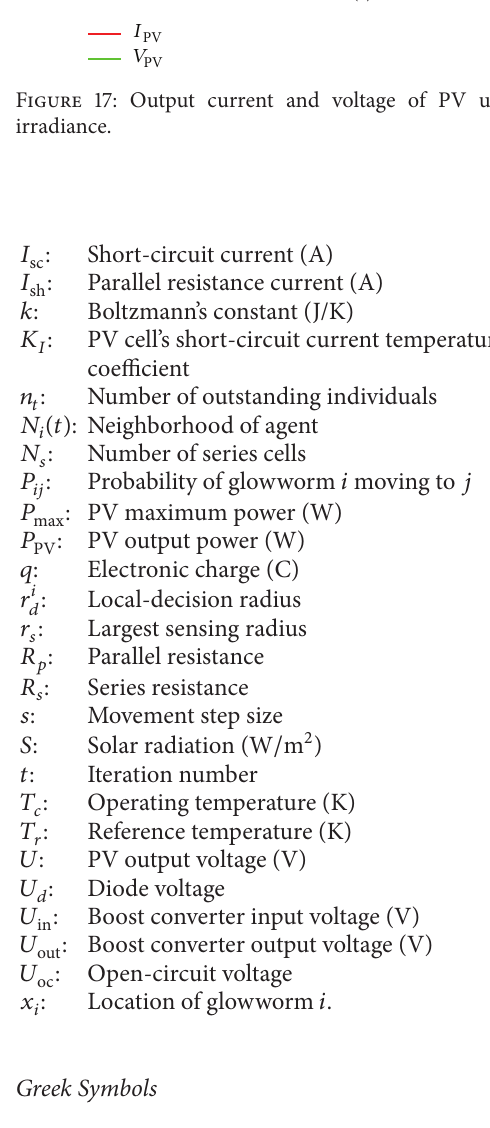
Figure 15: Condition of variable radiance.